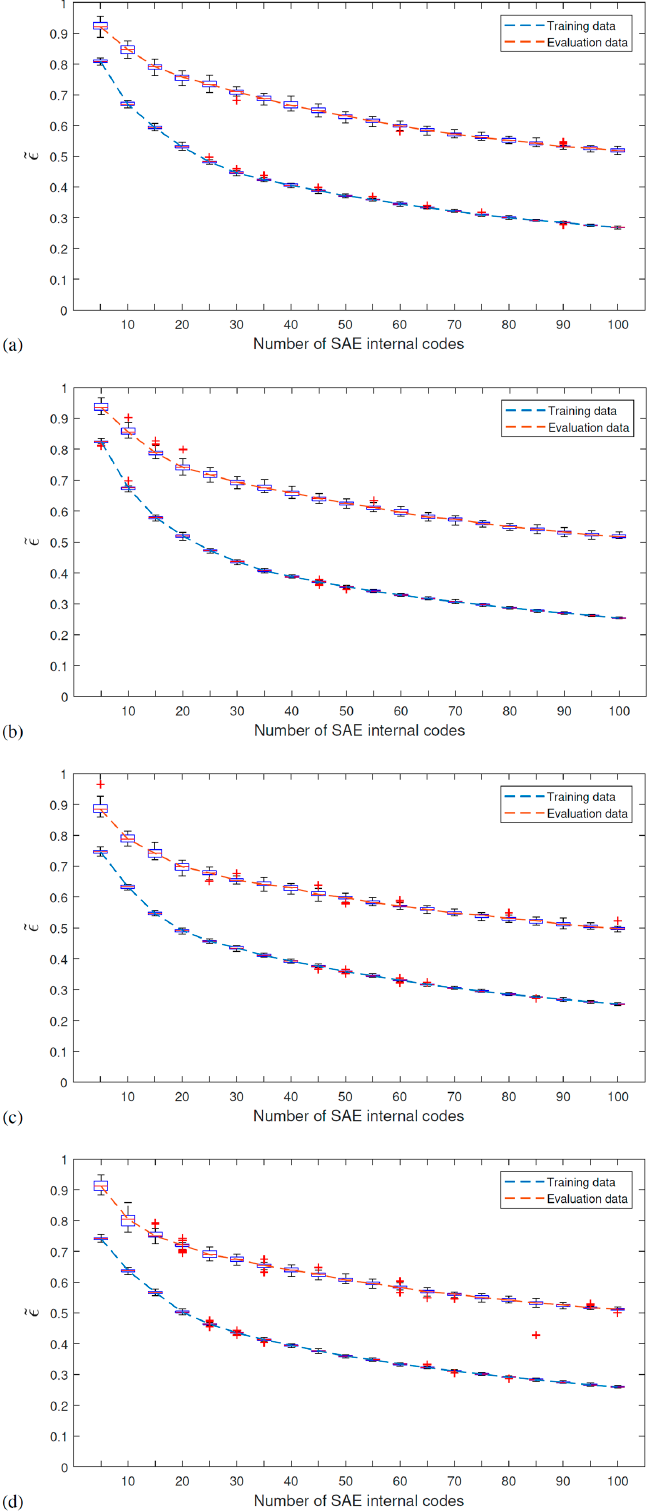
Figure 5. SAE internal codes × SAE reconstruction error for the numerical beam. ( a ) Measurement point Ac1. ( b ) Measurement point Ac2. ( c ) Measurement point Ac3. ( d ) Measurement point Ac4.